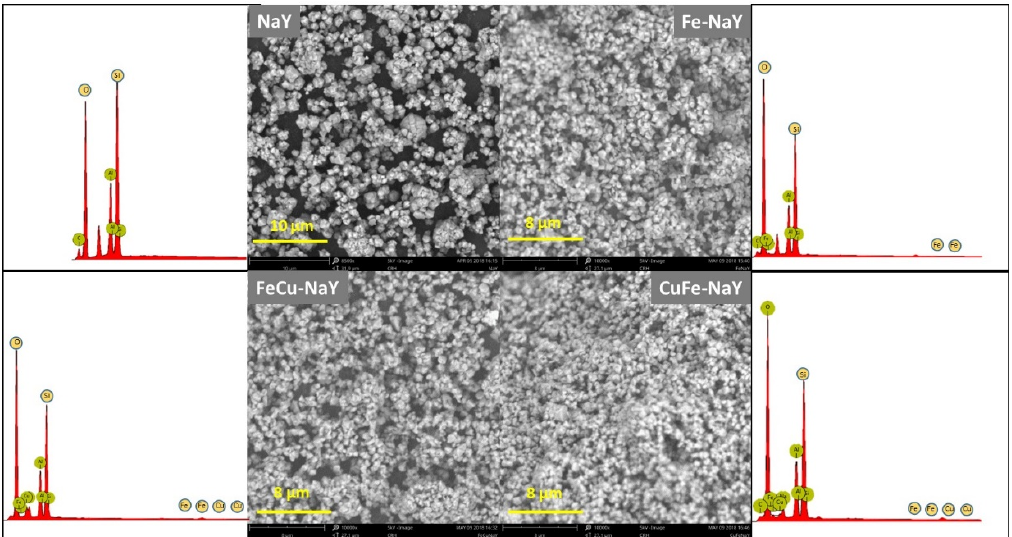
Figure 6. SEM micrographs and energy-dispersive X-ray (EDX) spectrum of the parent NaY and of the Fe-NaY, FeCu-NaY, and CuFe-NaY catalysts.